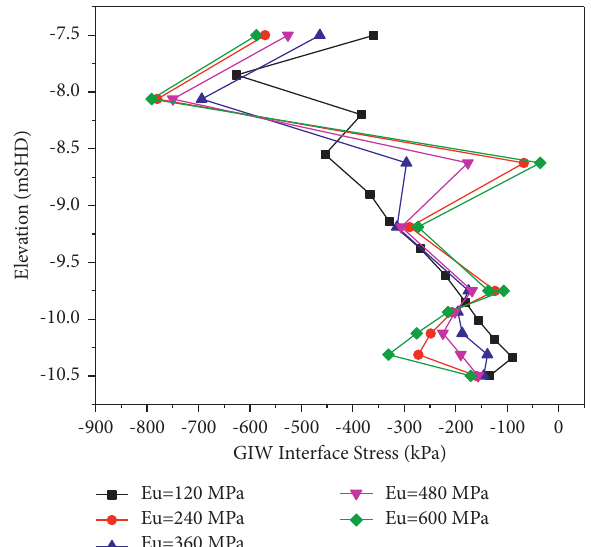
Figure 17: The effect of ground improvement Eu on GIW interface